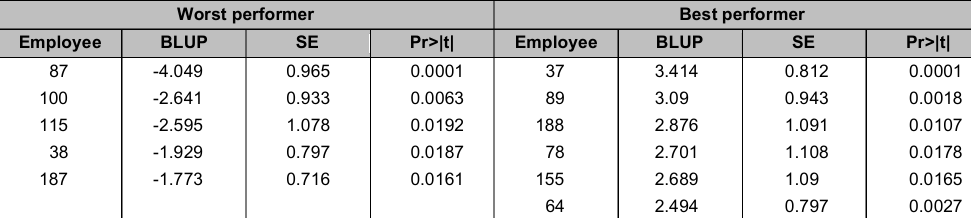
The worst and best performing employees when the raters’ effect is treated as being a random effect